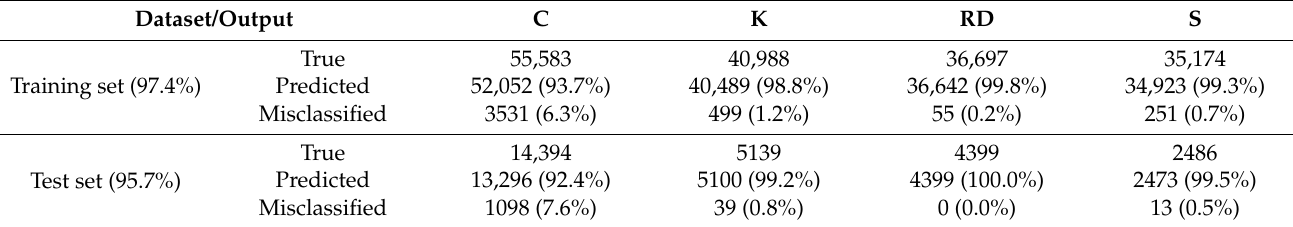
Table 2. Transmitted light added mean particle intensity (AMPI) classification model results on the training and test datasets using particles from single-material samples.